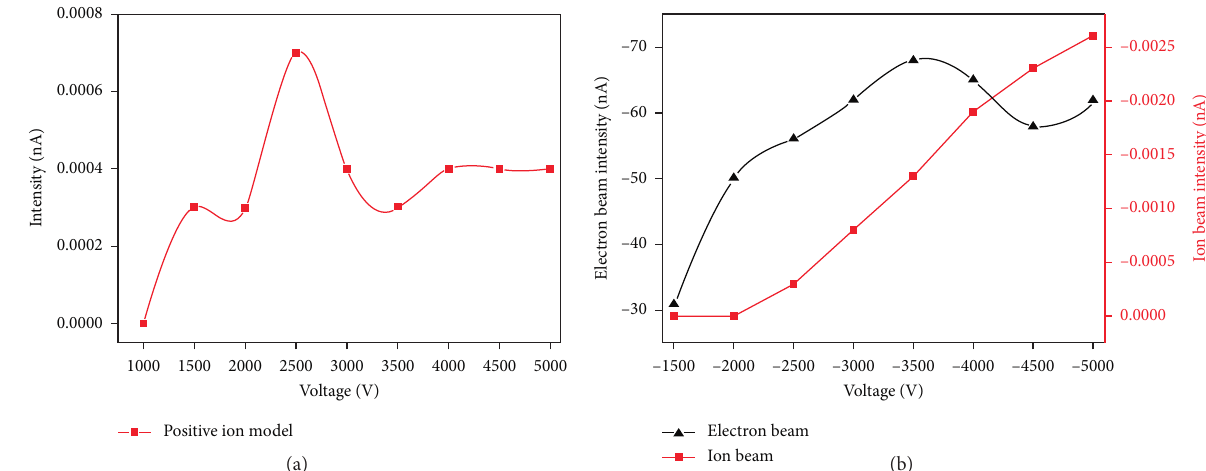
Figure 7: Relationship between ion signal intensity and repeller potential: (a) positive ion mode; (b) negative ion